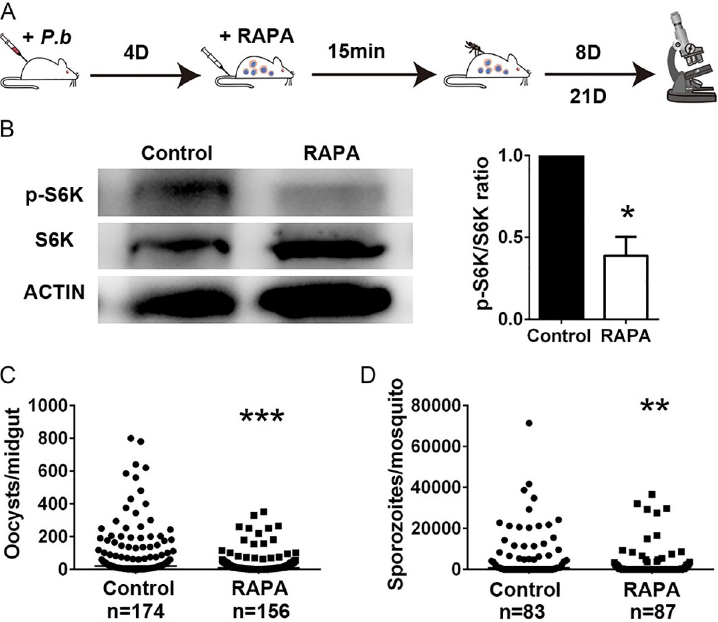
Fig 2. Feeding on rapamycin-treated mice influences P . berghei infection in An . stephensi . (A) Schematic overview of rapamycin treatment in mice. Vehicle solution-treated mice were used as controls. (B) Western blot analysis of S6K phosphorylation in fat bodies collected from mosquitoes that fed on rapamycin-treated mice. The bar chart represents the relative quantification of signal intensities from two independent replicates as determined by ImageJ software. Error bars indicate standard errors. (C) Oocyst numbers in mosquitoes feeding on rapamycin (RAPA)-injected and control mice. Data were pooled from three independent biological experiments. (D) Sporozoite numbers from mosquitoes feeding on rapamycin (RAPA)-injected and control mice. Data were pooled from two independent biological experiments. Horizontal black bars indicate the median values. Significance was determined by Student’s t - test in (B), and by Mann-Whitney tests in (C) and (D); � P < 0.05, �� P < 0.01, ��� P < 0.001.